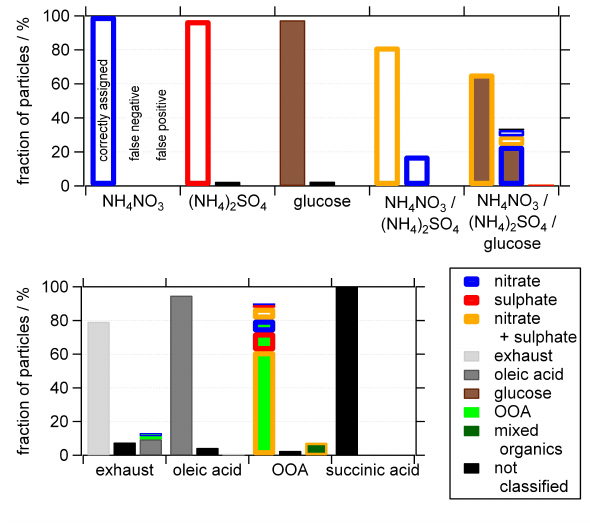
Fig. 3. Qualitative validation of the algorithm. On the x axis the dif- ferent particle types of known composition (compare Table 1) are shown. For each particle type, the left bar shows the fraction of cor- rectly assigned particle mass spectra, the middle bar the fraction of false negatives, and the bar on the right-hand side the fraction of false positives. The border colour of the bars represents the identi- fied inorganic content, the fill colour the identified organic content. Particles in which no component was identified are shown in black. For the particles of the OOA type, the exact content of nitrate, sul- phate and OOA is not known; therefore, all particle mass spectra have been regarded as correctly assigned where at least one of these components was